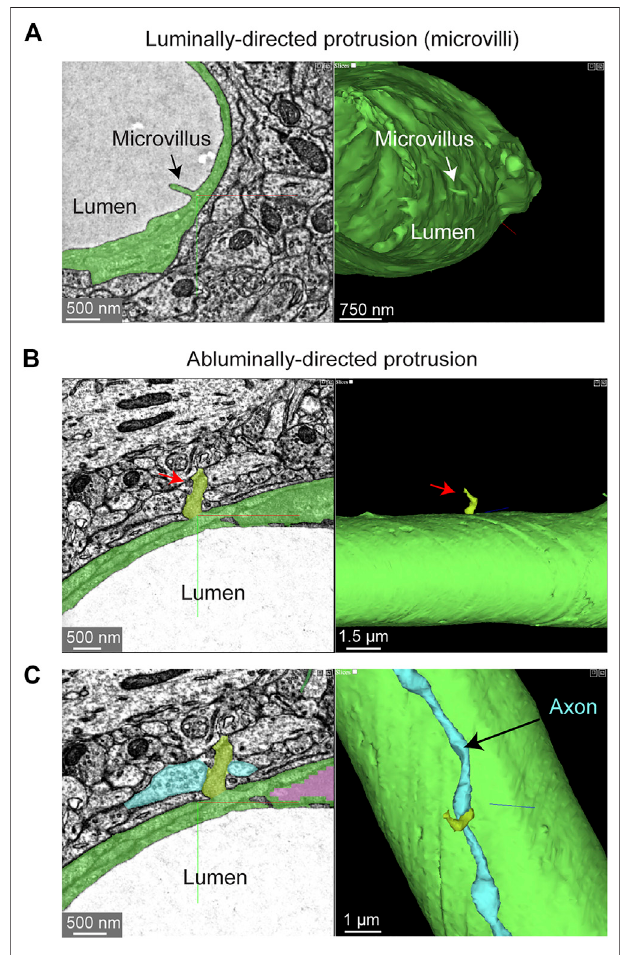
FIGURE 4 | Endothelial protrusions extend luminally and abluminally from thevesselwall. (A) Example ofaluminally-directed endothelialprotrusion (microvilli)within acapillary segment. Leftpanel shows the2D cross section of the structure (black arrow). Right panel shows a 3D view of the same structure in segmented vasculature (white arrow). MICrONS Layer 2/3 x, y, z coordinates at: 62431, 48503, 1336. (B) Example of abluminally-directed endothelial protrusion. Left panel shows the 2D cross-section of the structure (black arrow). Right panel shows a 3D view of the same structure in segmented vasculature. MICrONS Layer 2/3 x, y, z coordinates at: 73675, 48870,746.Thestructureissegmentedseparatelyfromthevascularwall,but is in fact an extension of the endothelial cell. (C) The abluminally-directed endothelial protrusion is surrounded by neuronal axons and dendrites. One axon (cyan) exhibits a region of swelling (potential bouton) in direct contact with the endothelial structure.